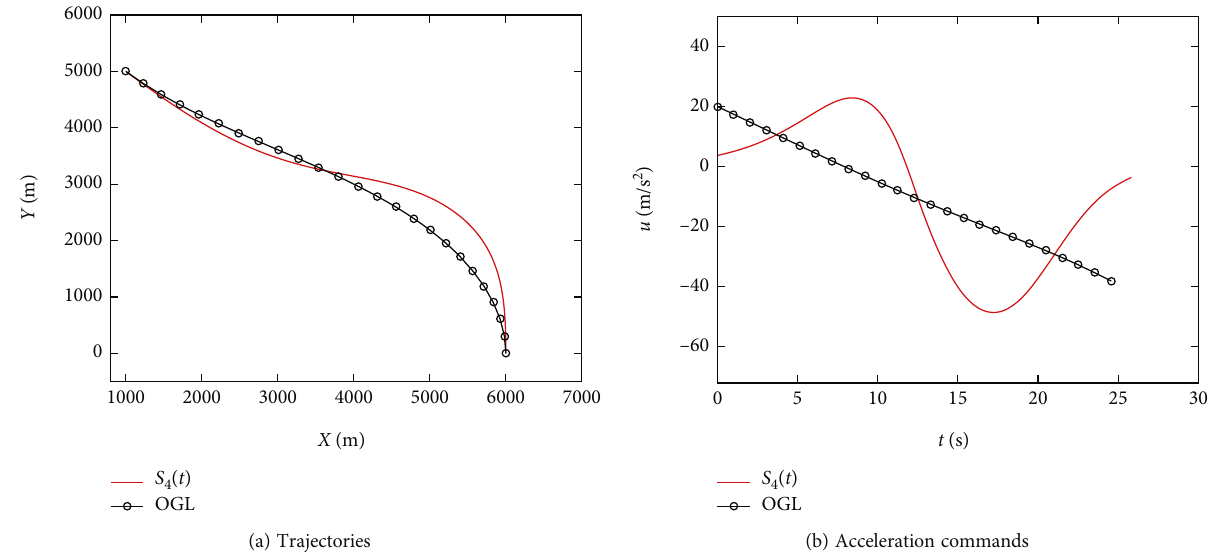
ð 0 Þ = − 45 ° , γ = − 90 ° f m